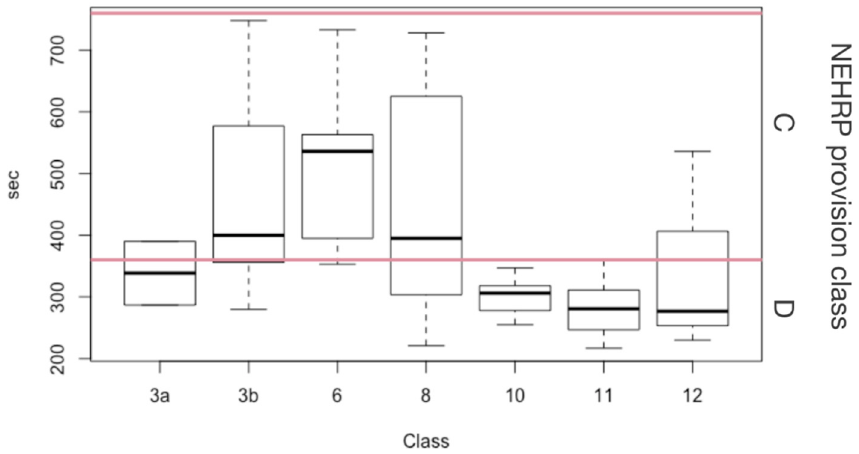
Figure 8. V S30 based on OBC geomorphological units; the red lines indicate the NEHRP classes.